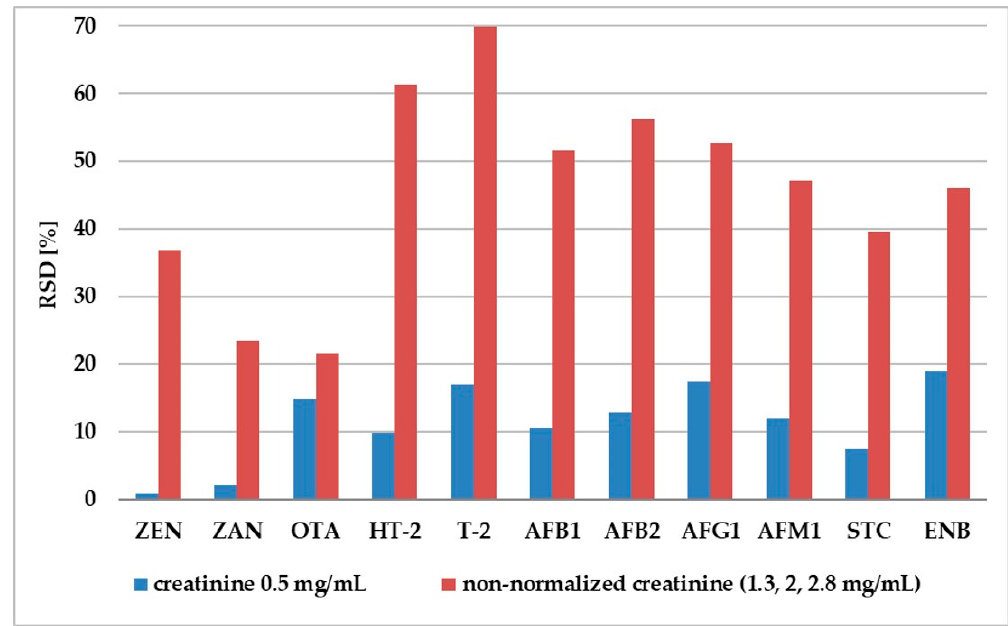
Figure 5. Comparison of day-to-day precision (RSD) values of matrix factor for normalized (urinary creatinine = 0.5 mg mL -1 in six replicates) and non-normalized urine (variance between results of mycotoxin analysis in three different creatinine levels: 1.3, 2, 2.8 mg mL -1 ).